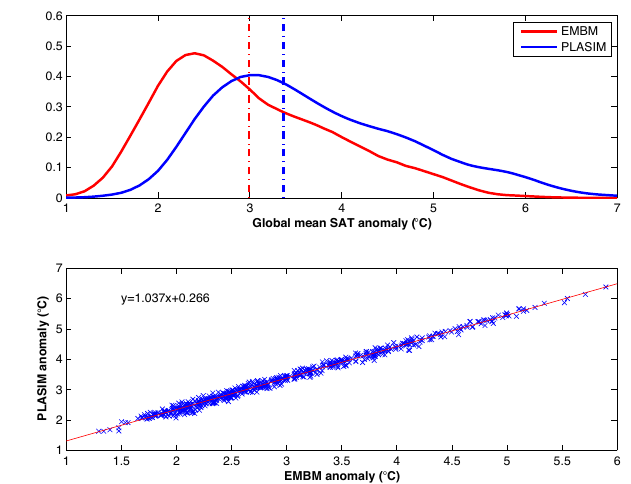
Figure 10. The upper panel shows the probability distributions of EMBM (red) and PLASIM (blue) climate sensitivities. The mean of each distribution is denoted by the dot-dashed line of the same colour. The lower panel shows a plot of PLASIM anomalies against EMBM anomalies. The coefficients of the linear function fitted through the data are included in the